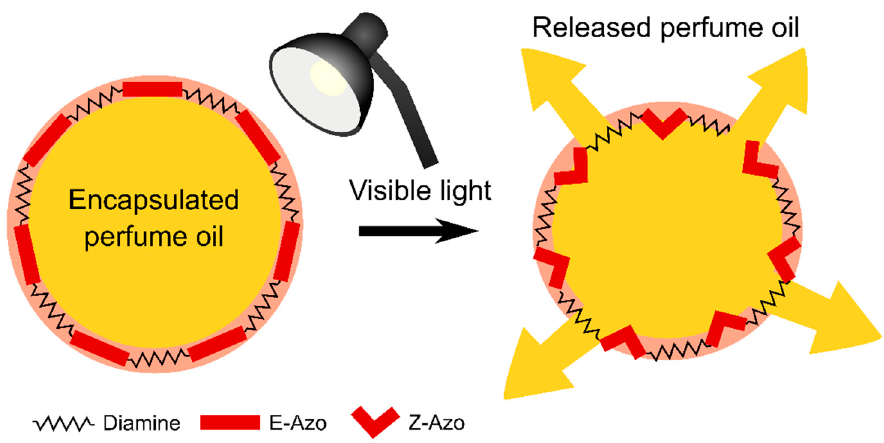
Figure 11. Schematic representation of release mechanism from azobenzene-based microcapsules.